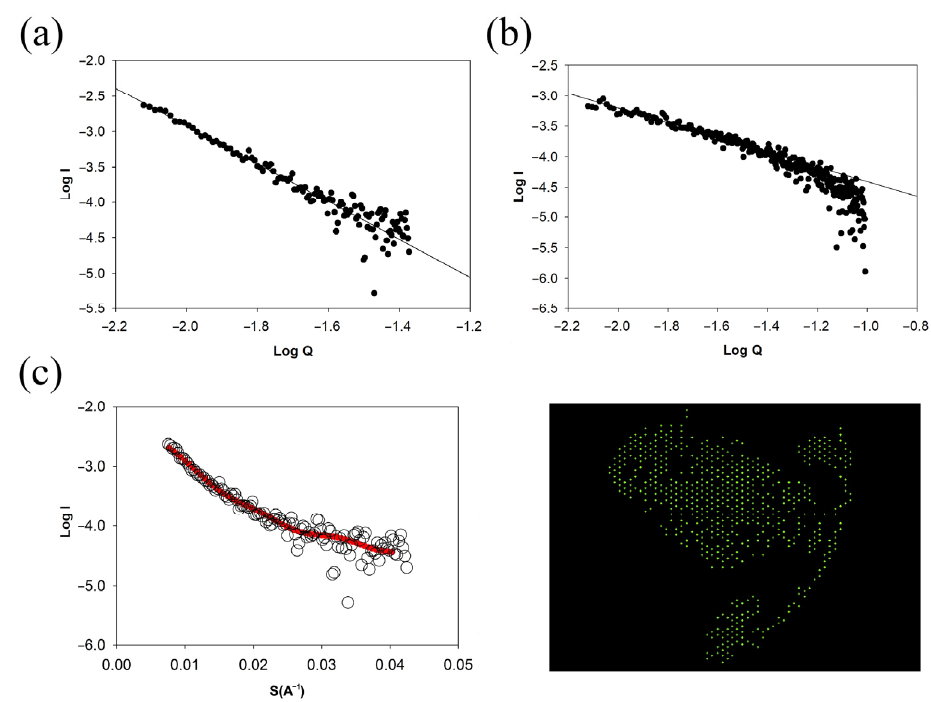
Figure 6. Investigation of the structure of SMT HMW aggregates by small-angle X-ray scattering. ( a ) The scattering curve for molecular SMT HMW in logarithmic representation log I –log Q , where I is the scattering intensity in 0.6 M KCl, c = 0.5 mg/mL (non-aggregated protein form), Q is the scattering vector, tan A = − 2.7; ( b ) SMT HMW in 0.15 M Gly (aggregated); Q , scattering vector; tan A = − 2.65; ( c ) SMT HMW in 0.6 M KCl, c = 0.5 mg/mL; dark line, approximation by the DAMMIF program.